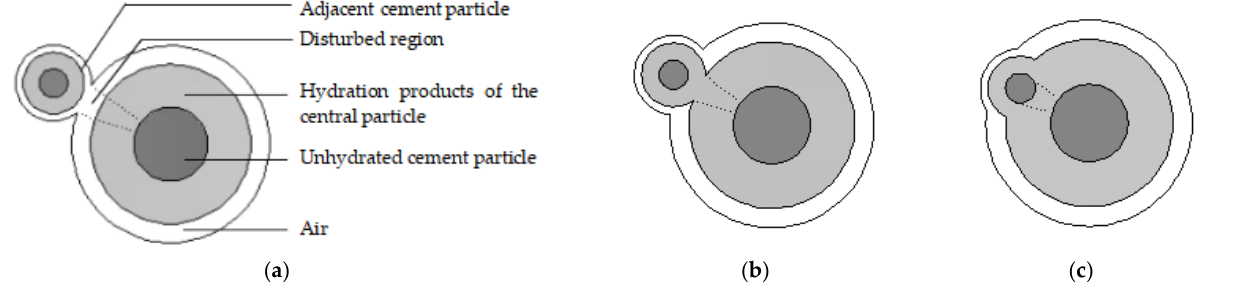
Figure 2. Hydration state of single cement particles.